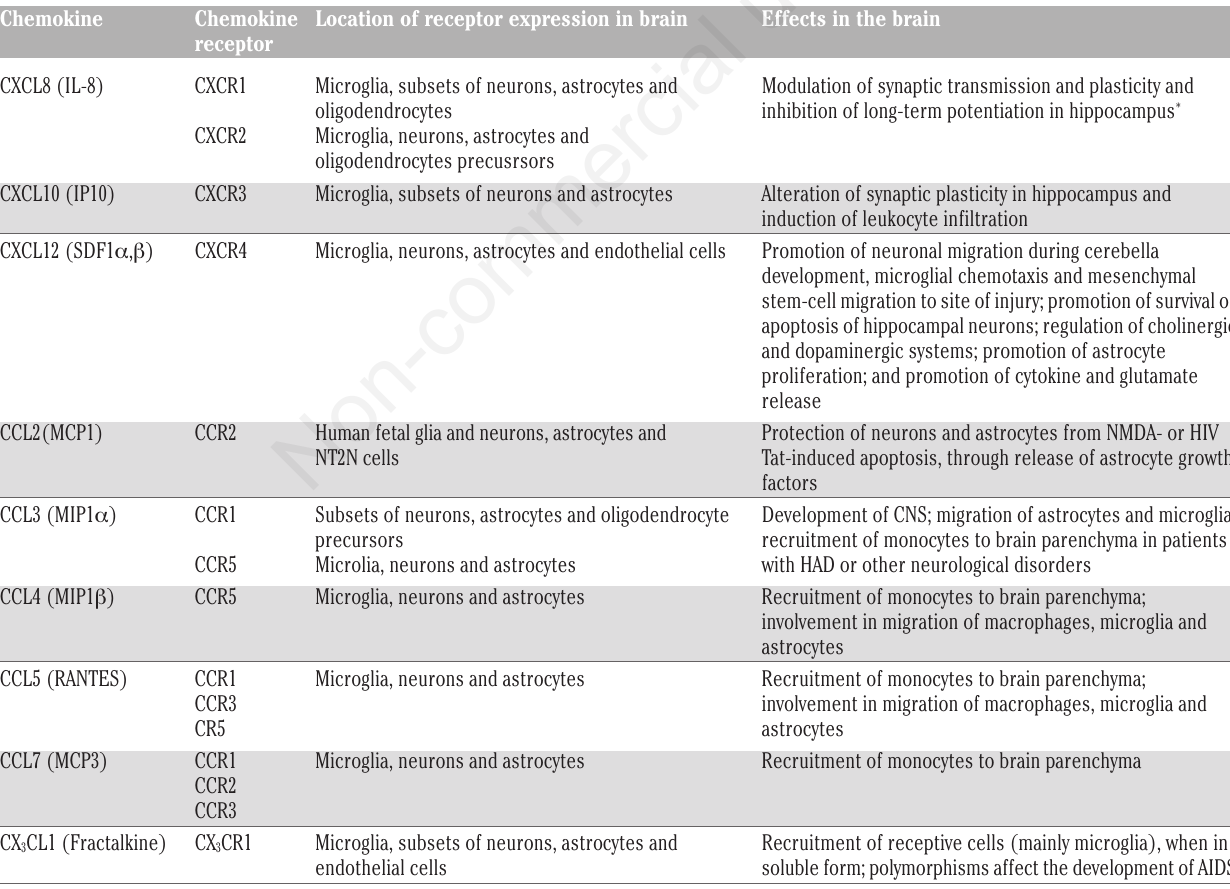
Table 1. Role of selected chemokines and chemokine receptors in HIV-associated dementia. Chemokine Chemokine Location of receptor expression in